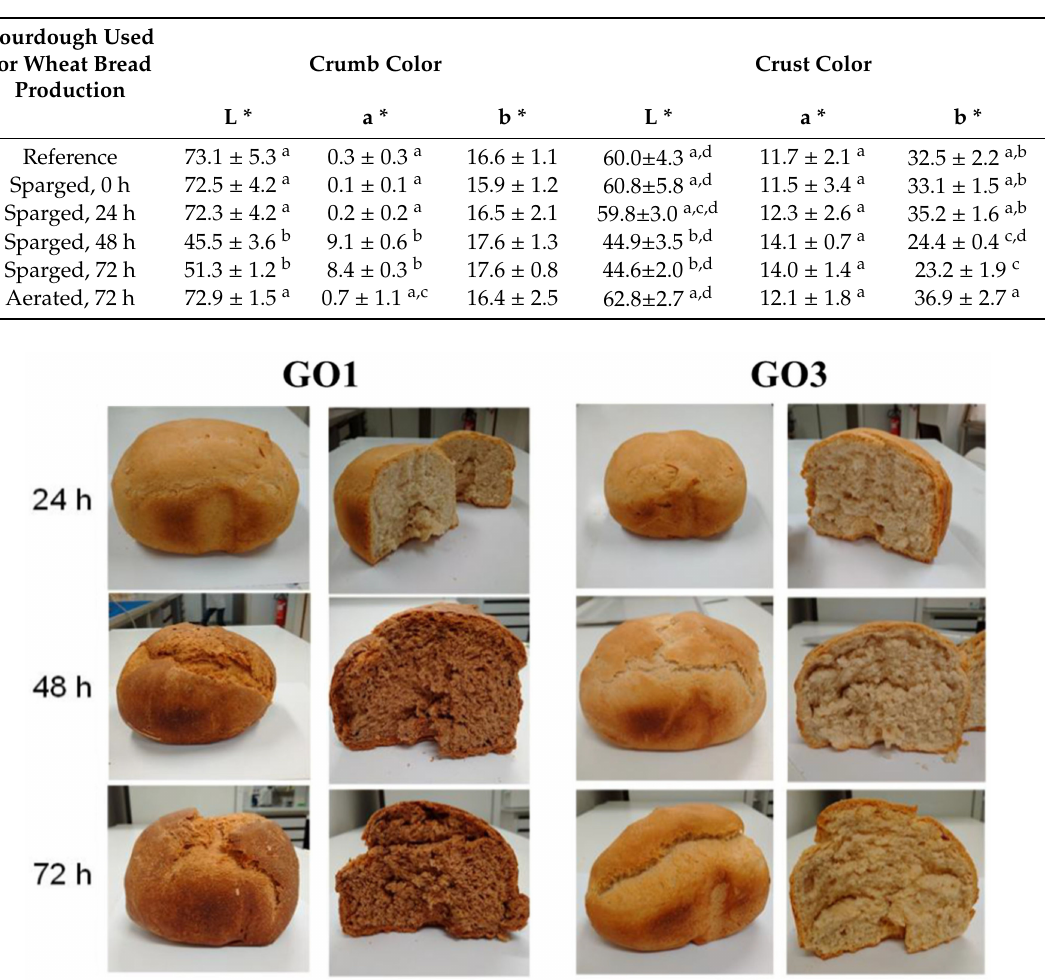
Table 4. Colorimetric evaluation, using L* (lightness), a* (green-red component), and b* (blue-yellow component) color values of the crumb and crust of wheat breads made with Gluconobacter oxydans IMDO A845-initiated sourdoughs (unfermented or fermented for 72 h) and aerated through the wheat flour–water mixture (sparged) or through the fermenter headspace (aerated). Statistically significant di ff erences among samples within each column are indicated by a letter in superscript.